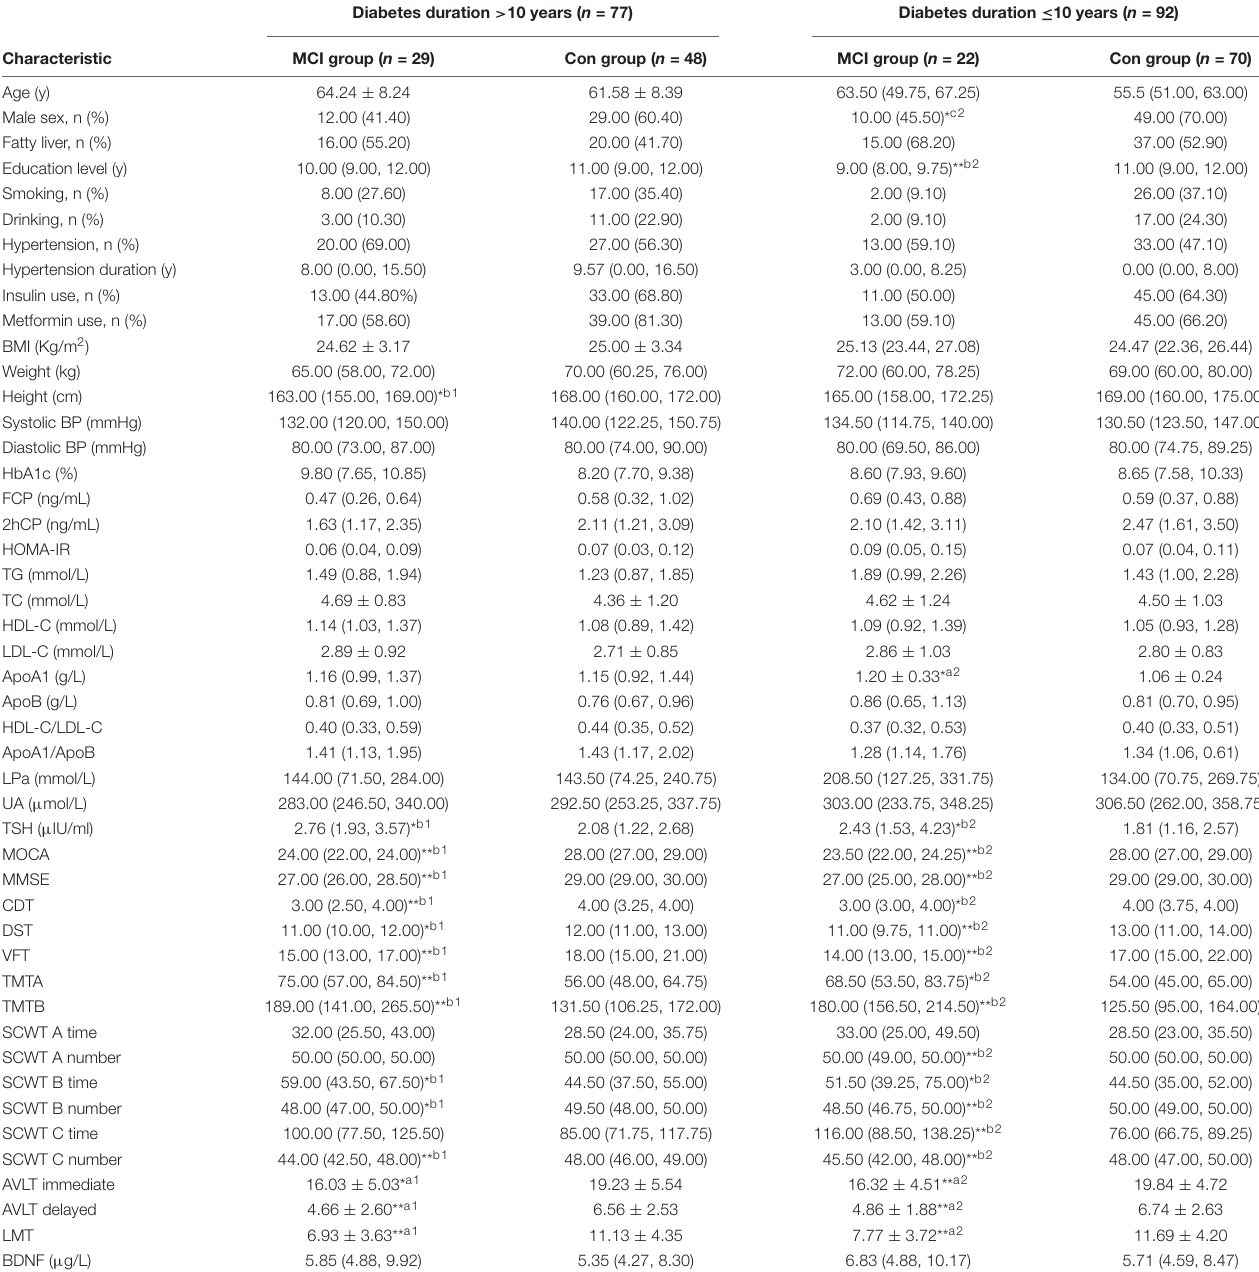
TABLE 1 | Baseline characteristics of T2DM patients with different